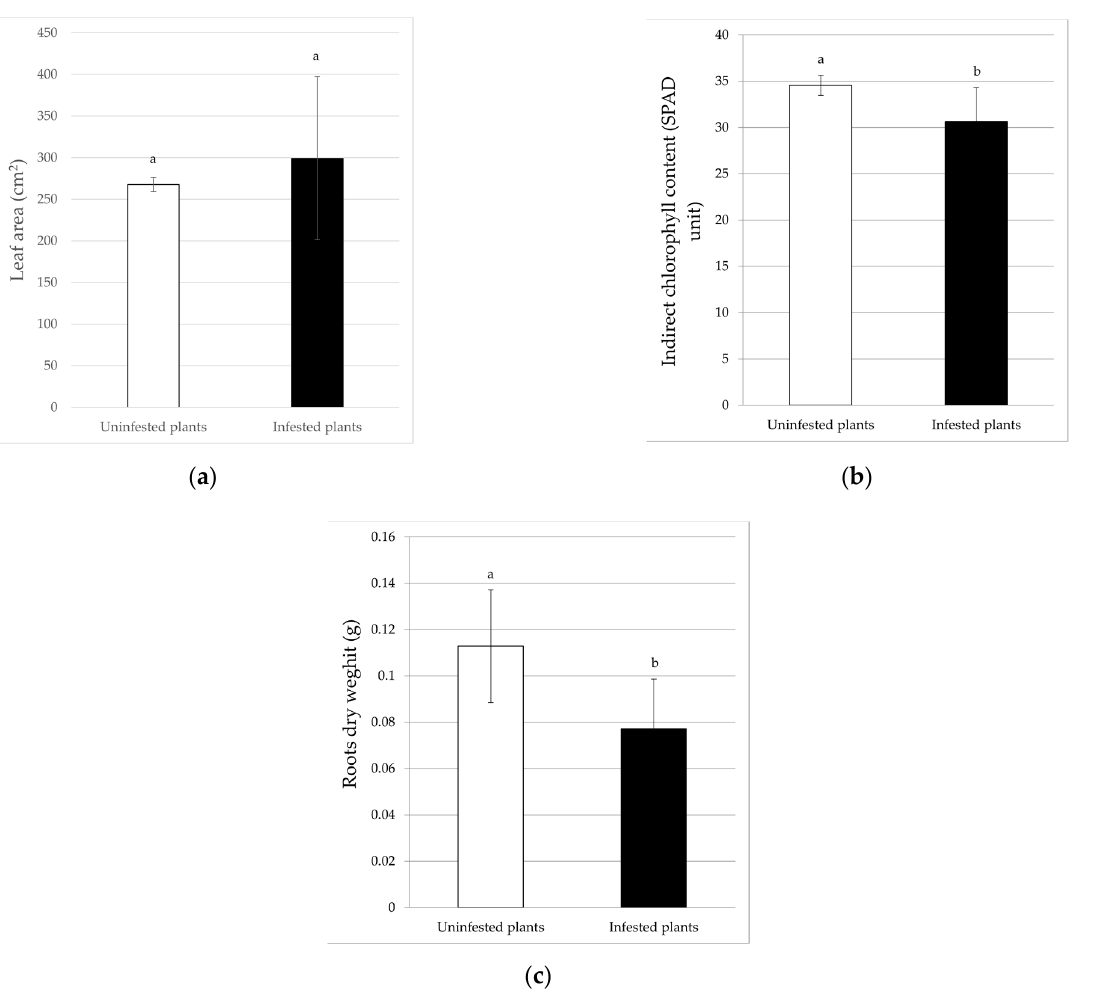
Figure 5. Effects of B. tabaci infestation on the leaf area ( a ), indirect chlorophyll content ( b ), and root dry weight ( c ) of eggplant plants. Different letters indicate statistical differences at p < 0.01.